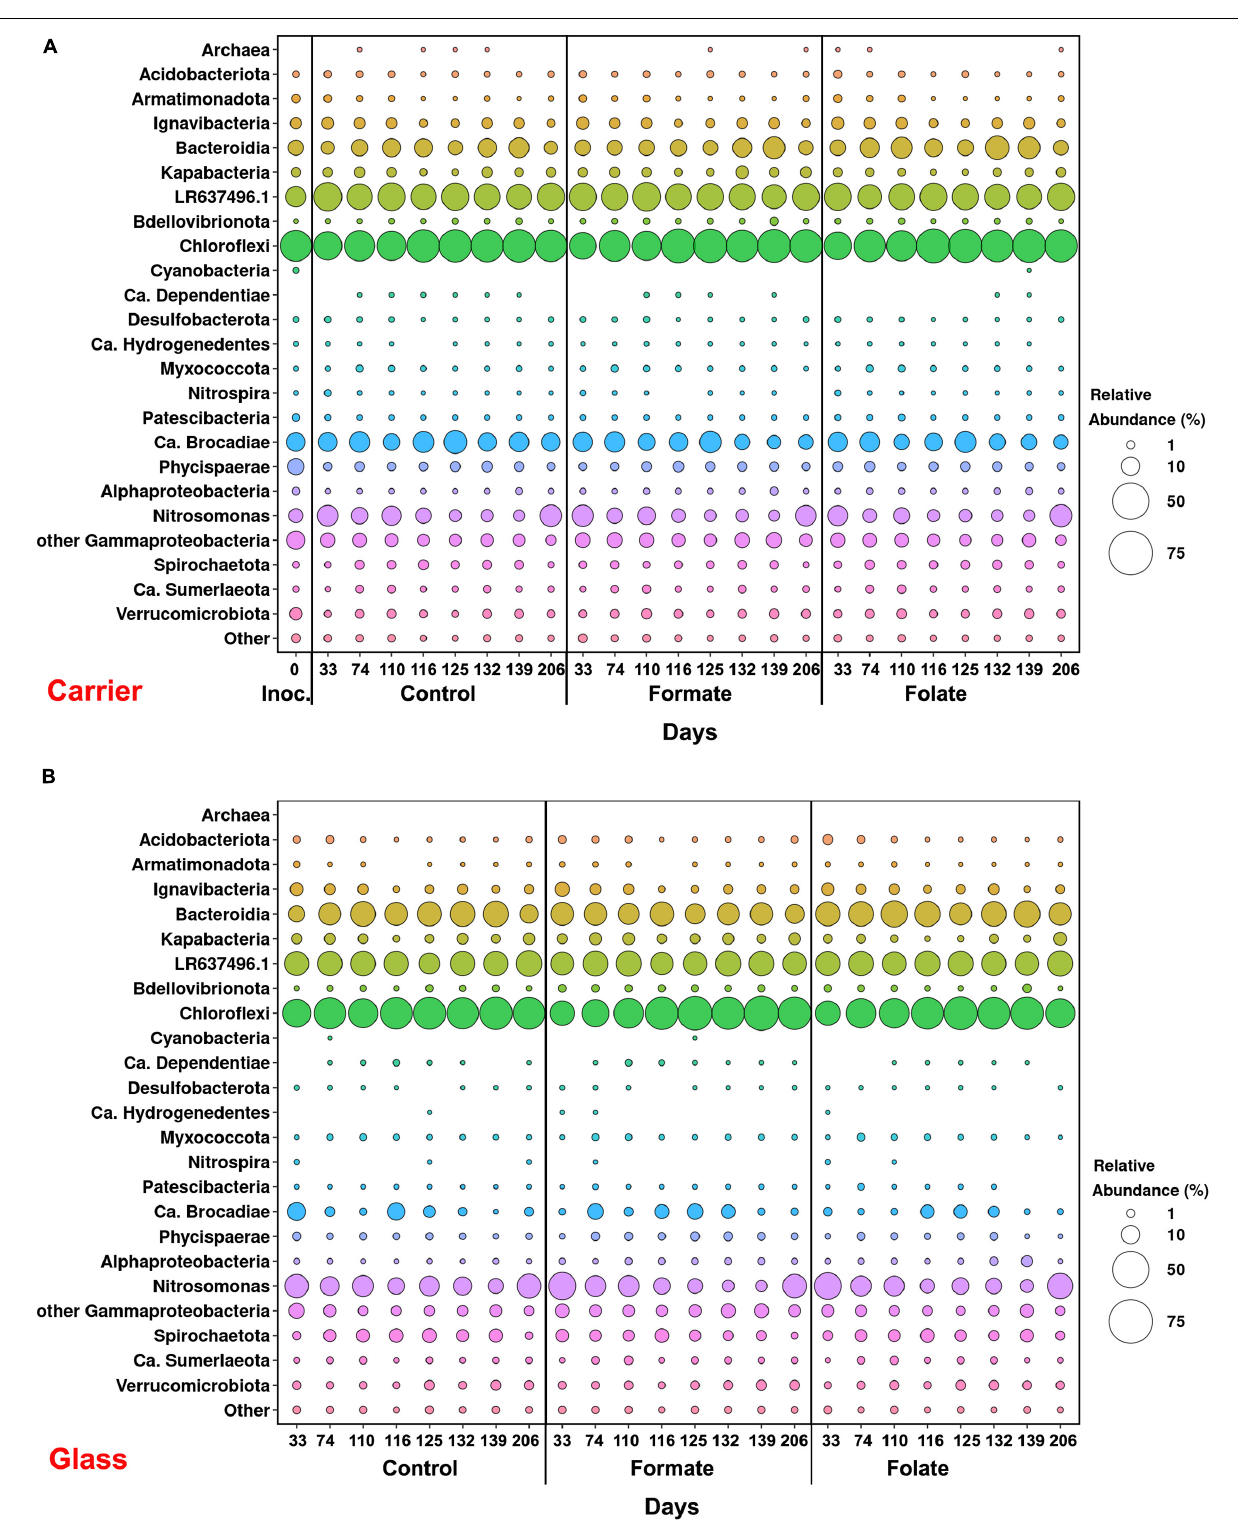
FIGURE 6 | The overall microbial diversity in the inoculum and the biomass on the carrier (A) and on the walls of the reactors (glass) (B) before (0–74 days) and after (110–206 days) the additives supplied and the ammonium load increased (the second run of the reactors) as revealed by high-throughput sequencing of the 16S rRNA gene